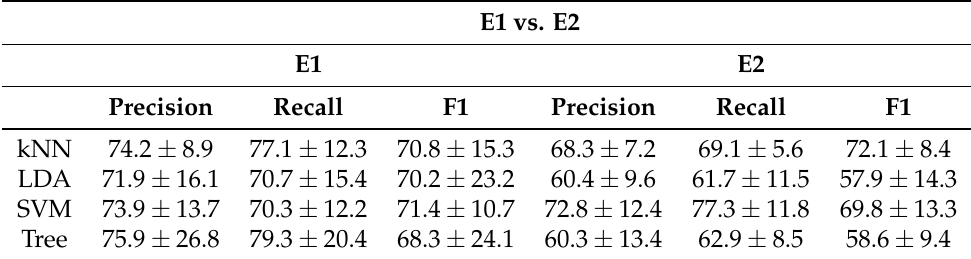
Table A2. Precision, Recall and F1 scores of the E1 vs. E2 classification problem.